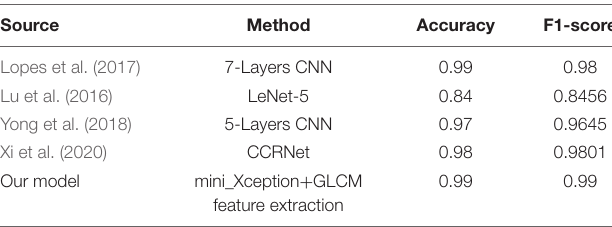
TABLE 2 | Comparison of performance on the dataset between different algorithms.